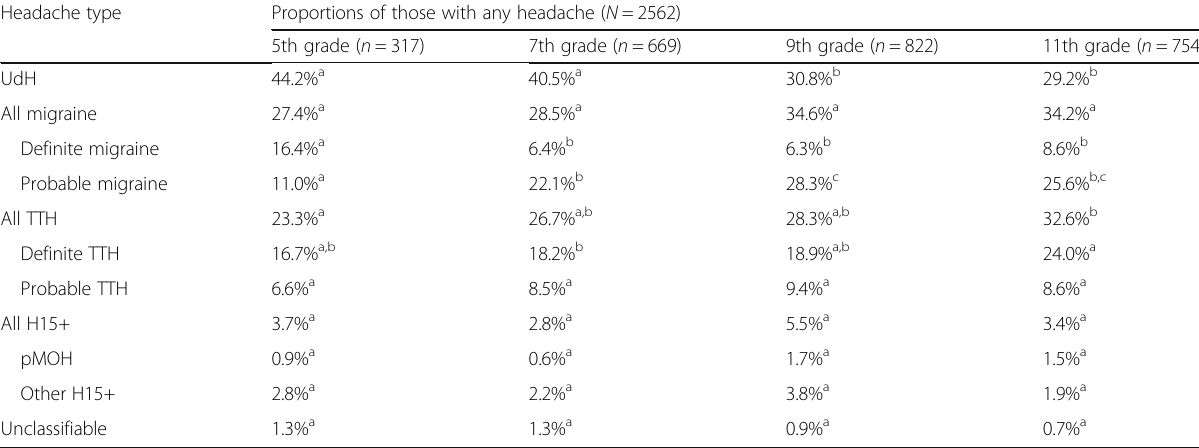
Table 3 Headache diagnoses by school grade among pupils (both genders) reporting headache during the preceding year Headache type Proportions of those with any headache ( N =